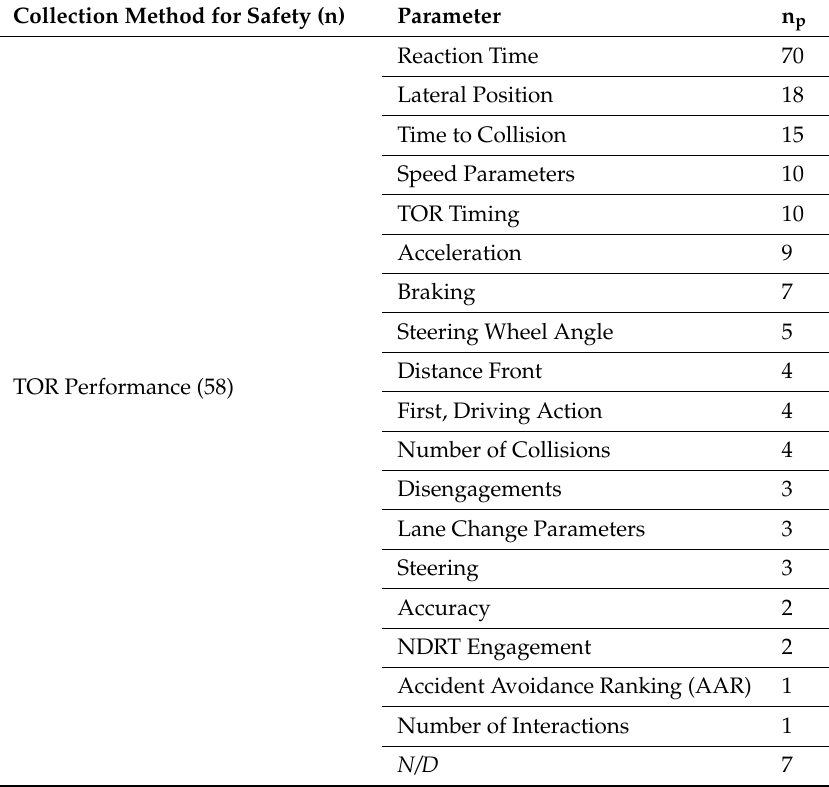
Table 2. Safety Collection methods and